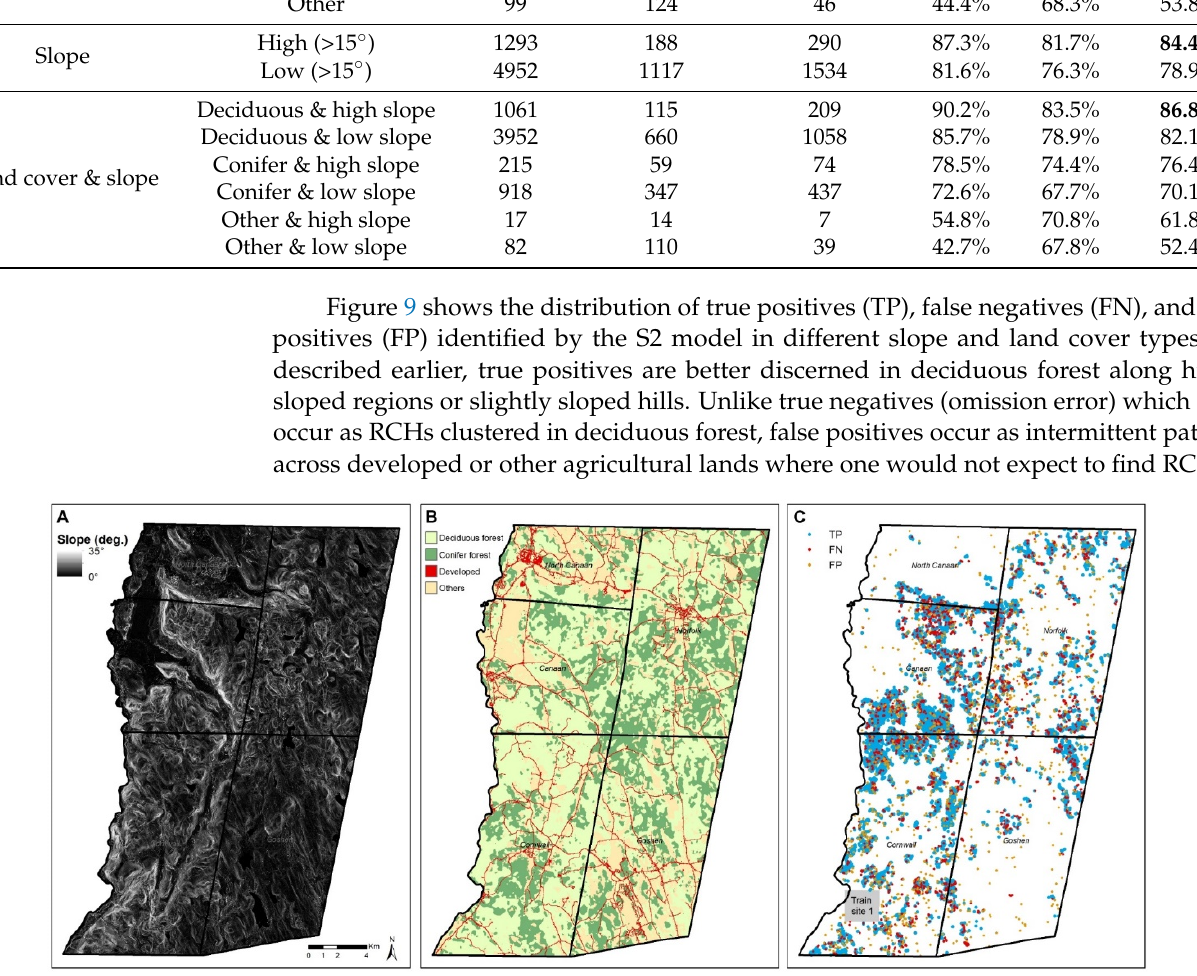
Figure 9. Slope map (generated from 1m LiDAR DEM) ( A ), land cover map (2015, 30 m resolution, provided by CT CLEAR) [48] ( B ), and S2 model prediction results for five towns (North Canaan, Canaan, Cornwall, Norfolk, and Goshen). RCHs in training site 1 were excluded during the accuracy assessment ( C ).